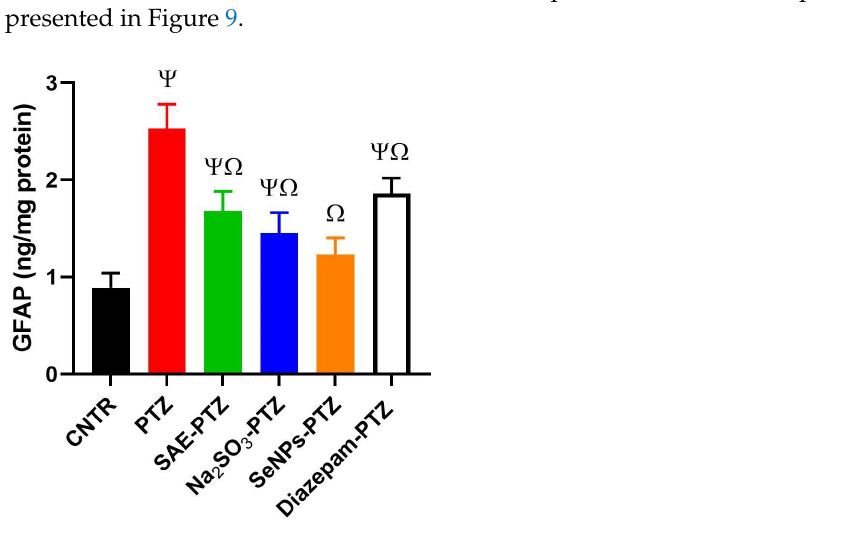
Figure 9. Effects of oral administration of Syzygium aromaticum extract (SAE), sodium selenite (Na 2 SeO 3 ), and green synthetized SeNPs using SAE (SAE-SeNPs) on protein expression of glial fibrillary acidic protein (GFAP) in cerebral cortex tissue responding to pentylenetetrazole (PTZ)-induced epileptic seizures ( n = 8). Ψ and Ω indicate significant differences ( p < 0.05) compared with the control and PTZ-exposed groups, respectively. All values are presented as the mean ± standard deviation (SD).